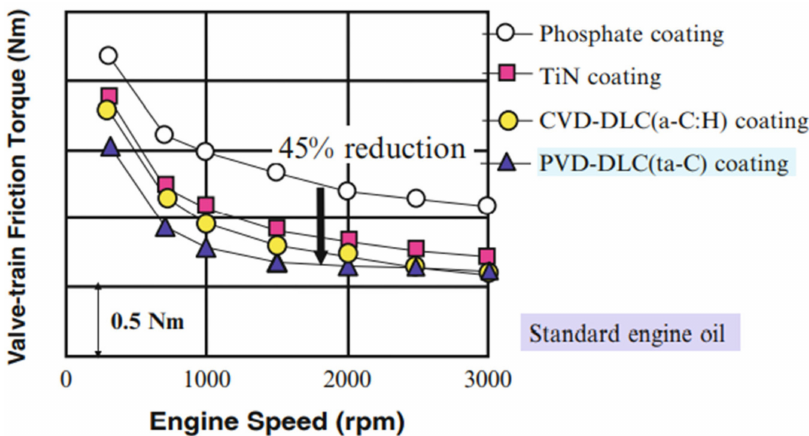
Figure 8. Friction reductions with different coatings on the valvetrain